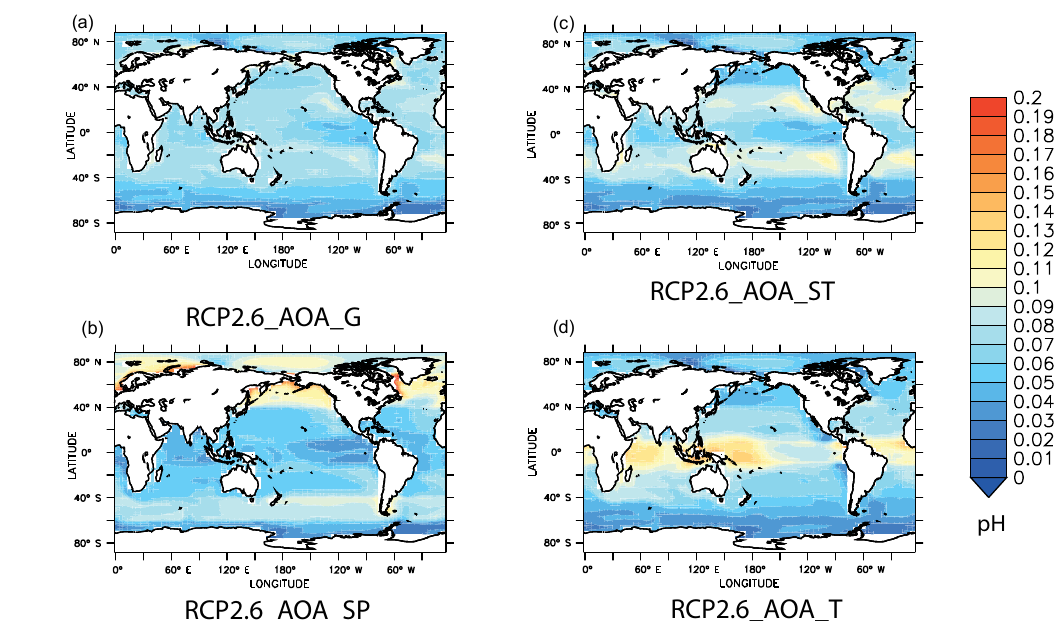
Figure 12. The spatial map of the changes in pH in 2090 (mean; 2081–2100) associated with global and regional AOA under RCP2.6, relative to RCP2.6 with no AOA.